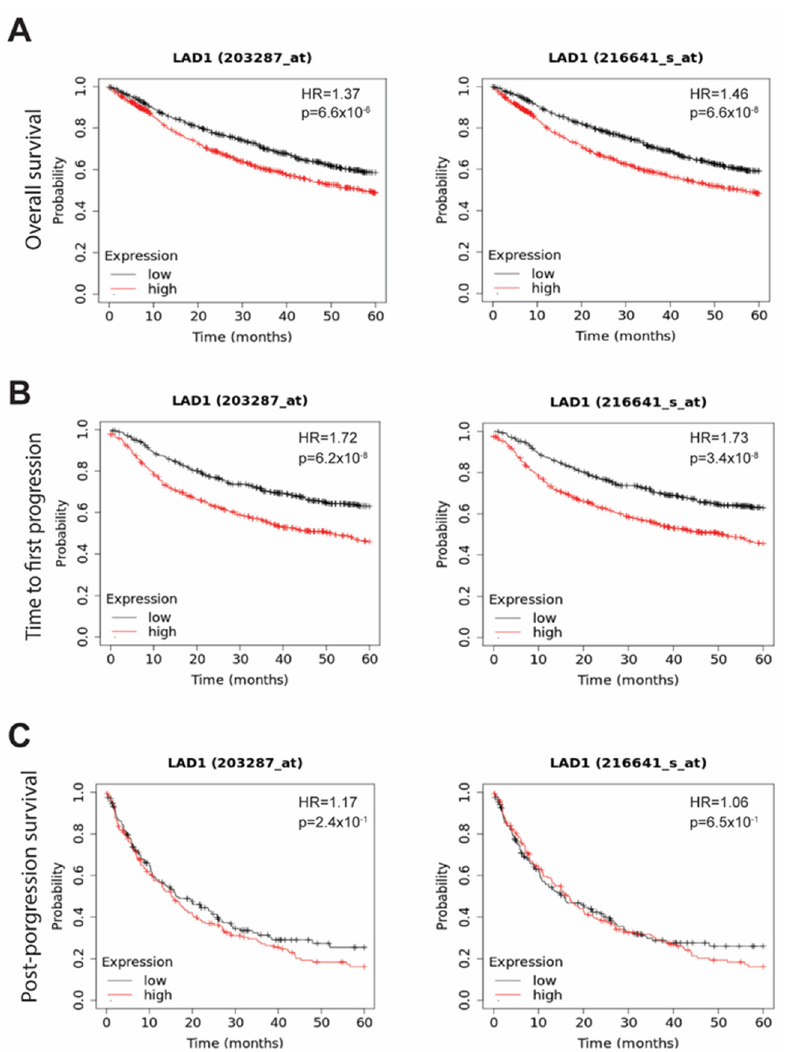
Figure 3. Five-year survival analysis of LAD1 expression in LUAD. ( A ) Poor outcomes of five-year overall survival, time to first progression ( B ), and post-progression survival ( C ) are associated with high LAD1 expression levels identified by the Kaplan − Meier plotter (KM plotter).